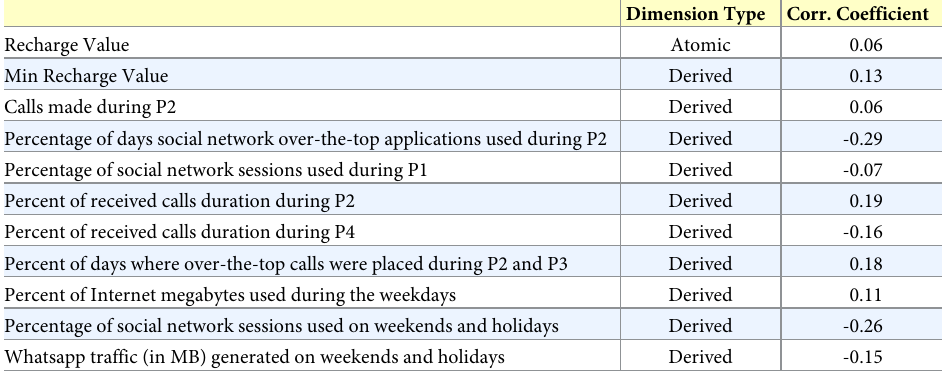
Table 4. Correlation of age with features used for